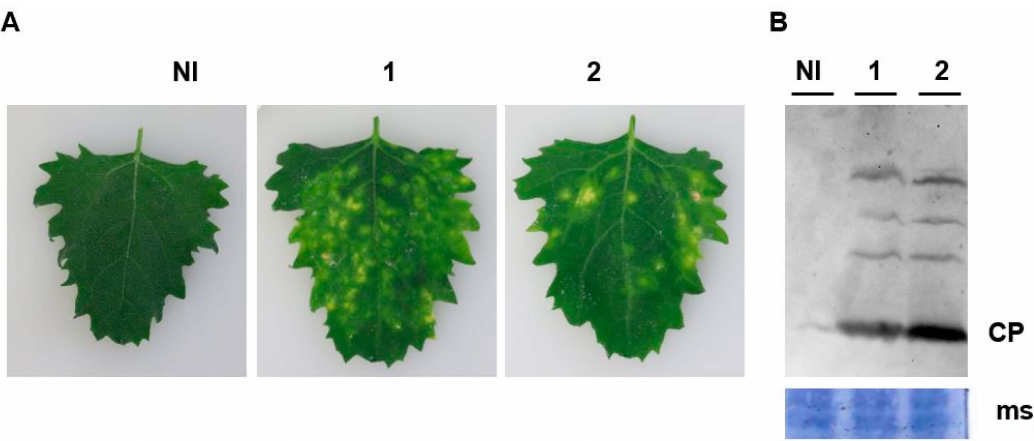
Figure 3. Capped transcripts RNAs 1 and 2 produced from USA BNYVV. ( A ) cDNA clone constructs are infectious in Chenopodium quinoa . Transcripts RNAs 1 + 2 combined and rub-inoculated to C. quinoa leaves induced chlorotic local lesions from 5 days postinoculation (panels 1–2). ( B ) Total proteins were extracted from local lesions and viral coat protein (CP) was detected by Western blot using anti-BNYVV antiserum (lanes 1–2). Membrane staining (MS) with Coomassie brilliant blue to provide a loading standard. Noninoculated (NI) plants were used as controls. 1 and 2 represent two plants inoculated with RNAs 1 + 2,